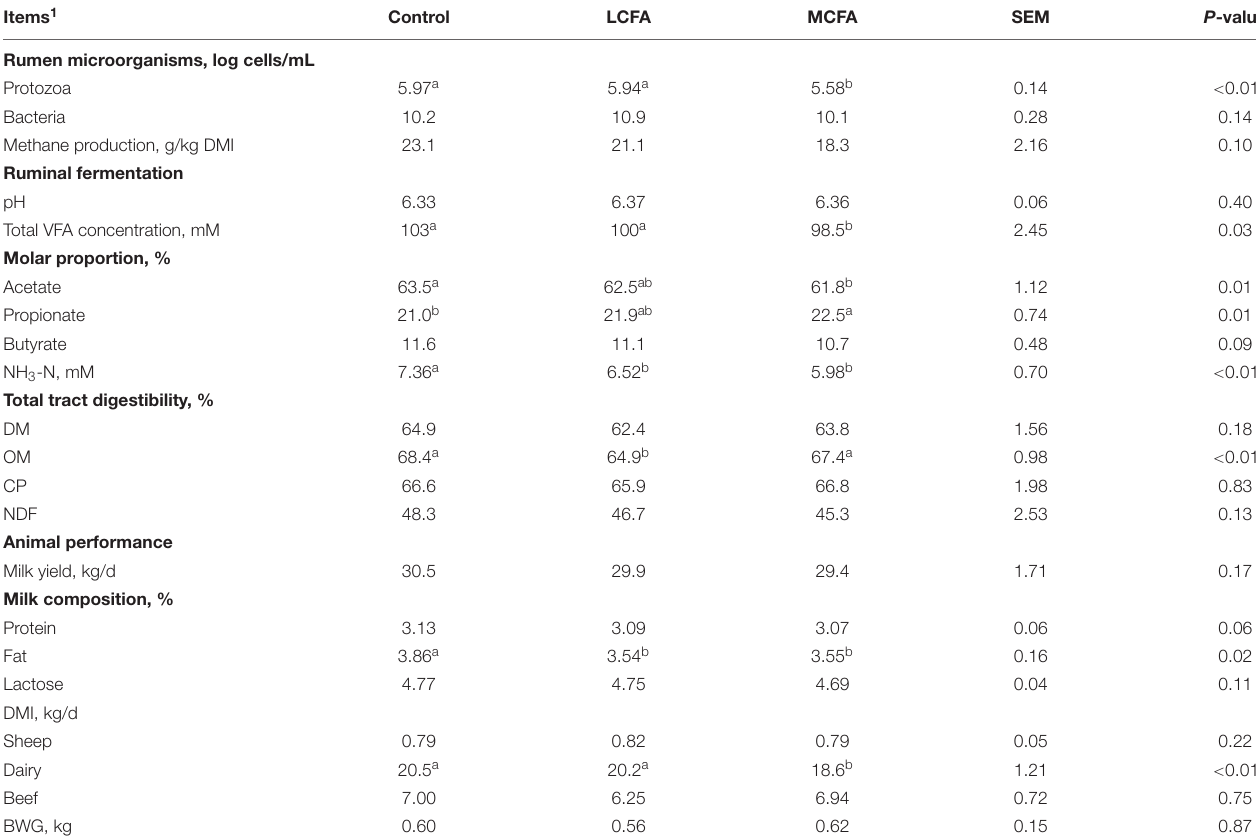
Items 1 Control LCFA MCFA